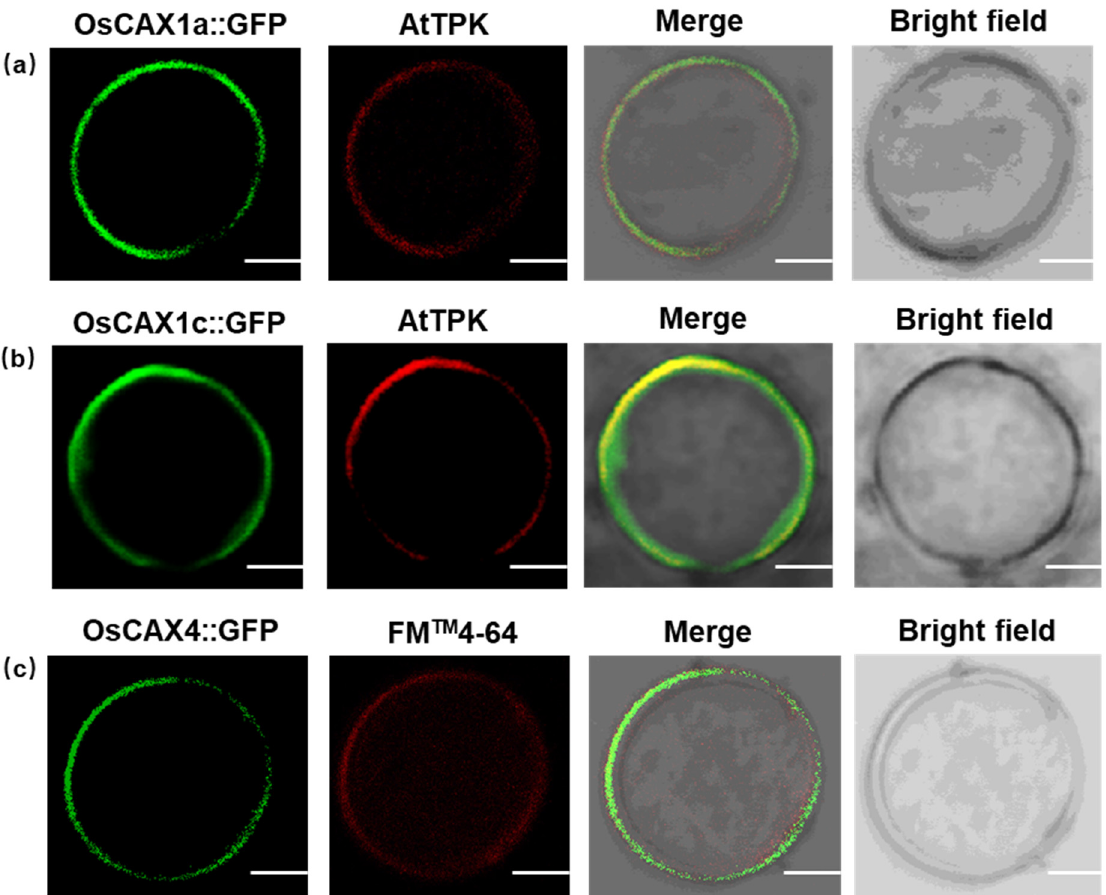
Figure 5. Subcellular location of OsCAX1a , OsCAX1c and OsCAX4 in rice protoplasts. ( a ) The fluorescence of OsCAX1a-GFP, AtTPK ( left ), and overlay of FM4–64 and OsCAX1a-GFP, bright field ( right ) are shown, respectively. ( b ) The fluorescence of OsCAX1c-GFP, AtTPK ( left ), and overlay of AtTPK and OsCAX1c-GFP, bright field ( right ) are shown, respectively. ( c ) The fluorescence of OsCAX4-GFP, FM TM 4–64 ( left ), and overlay of FM TM 4–64 and OsCAX4-GFP, bright field ( right ) are shown, respectively. Bars = 10 μ m.